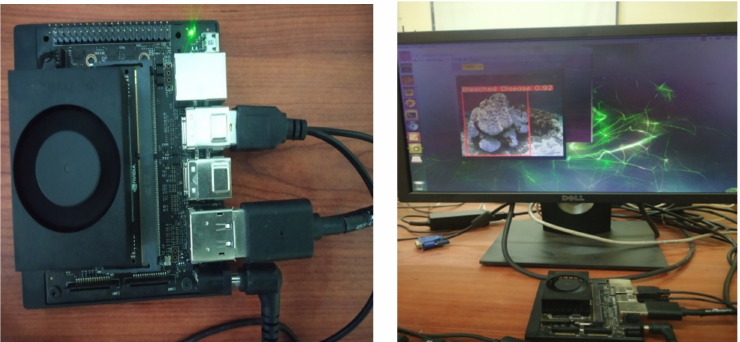
Figure 31. NVIDIA Jetson Xavier NX board-based coral-reef health detection system. Video Inference on NVIDIA Jetson Xavier NX Board